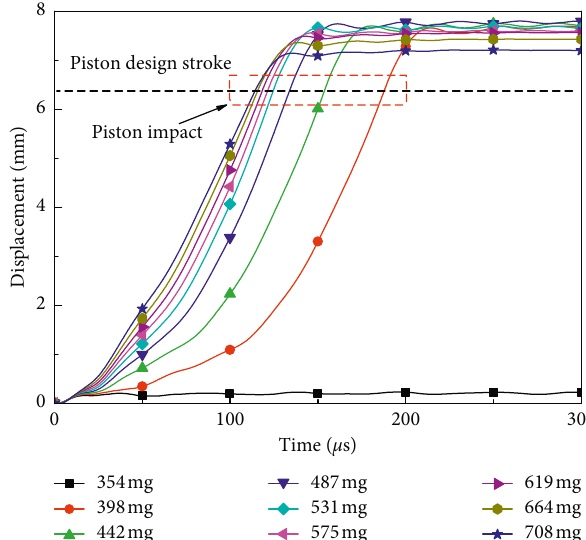
Figure 17: Velocities of the piston under different charge amounts.